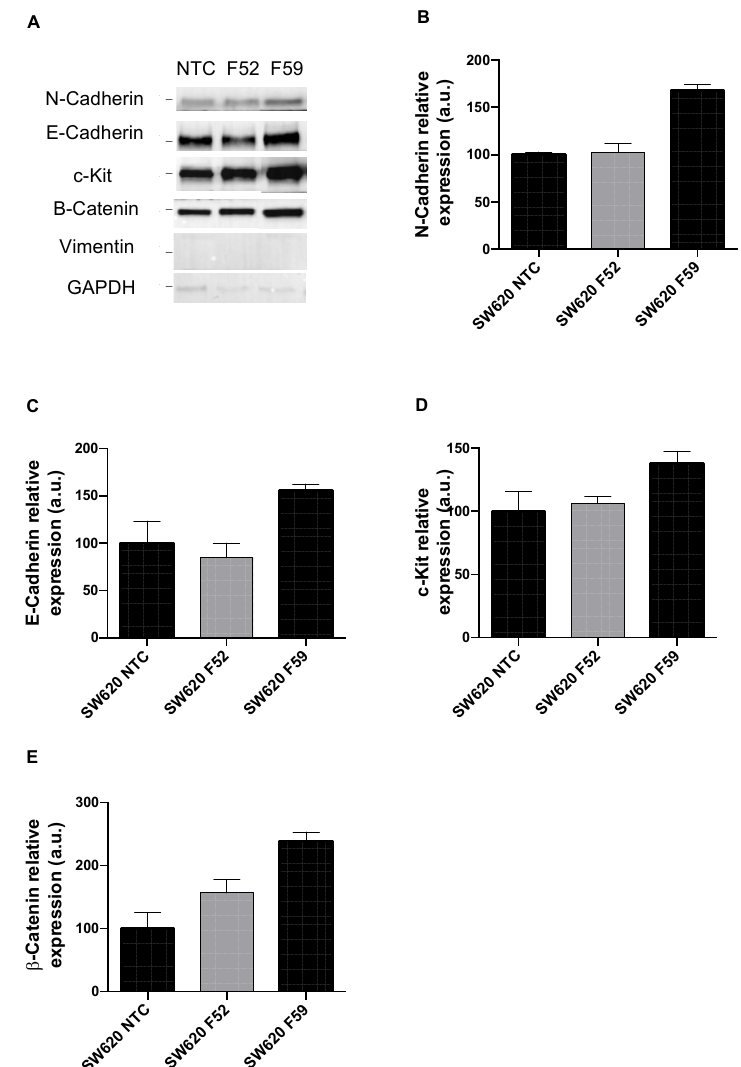
Figure 2. Impact of FUT8 downregulation on EMT markers in SW620 cell line. ( A ): Representative image of protein levels of EMT markers analyzed by Western blot in SW620 NTC and FUT8 -silenced clones F52 and 59. ( B – E ): Relative quantification of N-cadherin, E-cadherin, c-Kit, β -catenin, and vimentin using GAPDH protein expression as loading control. Measurements were plotted as mean ± SEM of two replicates. NTC clones were used as reference for statistical analysis.